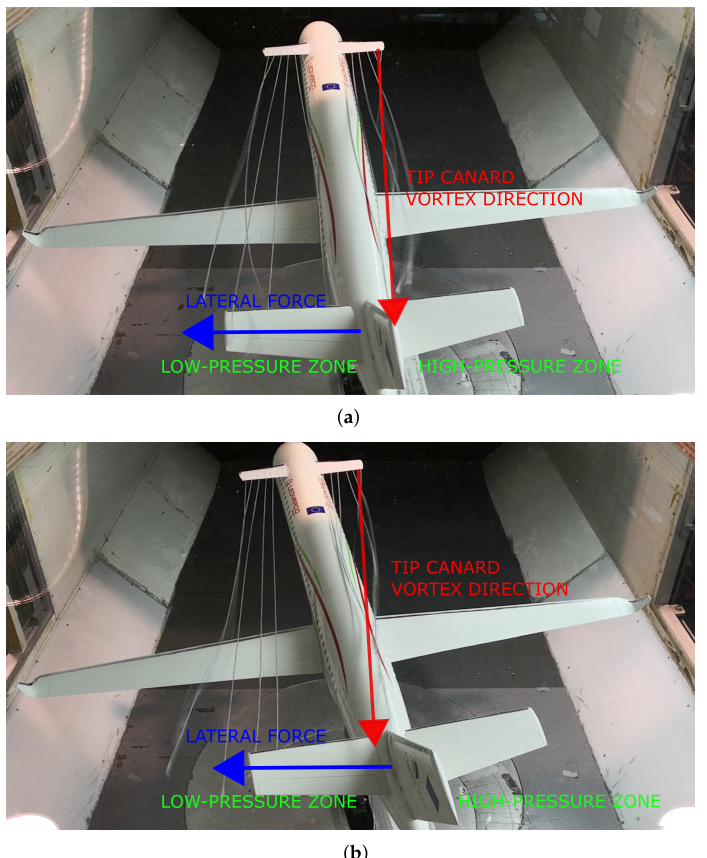
Figure 7. Canard wake impingement on the vertical tailplane: visualization test through wool yarns. V = 35m/s, Re = 315,000. ( a ) Canard tip vortex hitting upwind the vertical tail at β = 6°; ( b ) canard tip vortex hitting downwind the vertical tail at β = 12°.